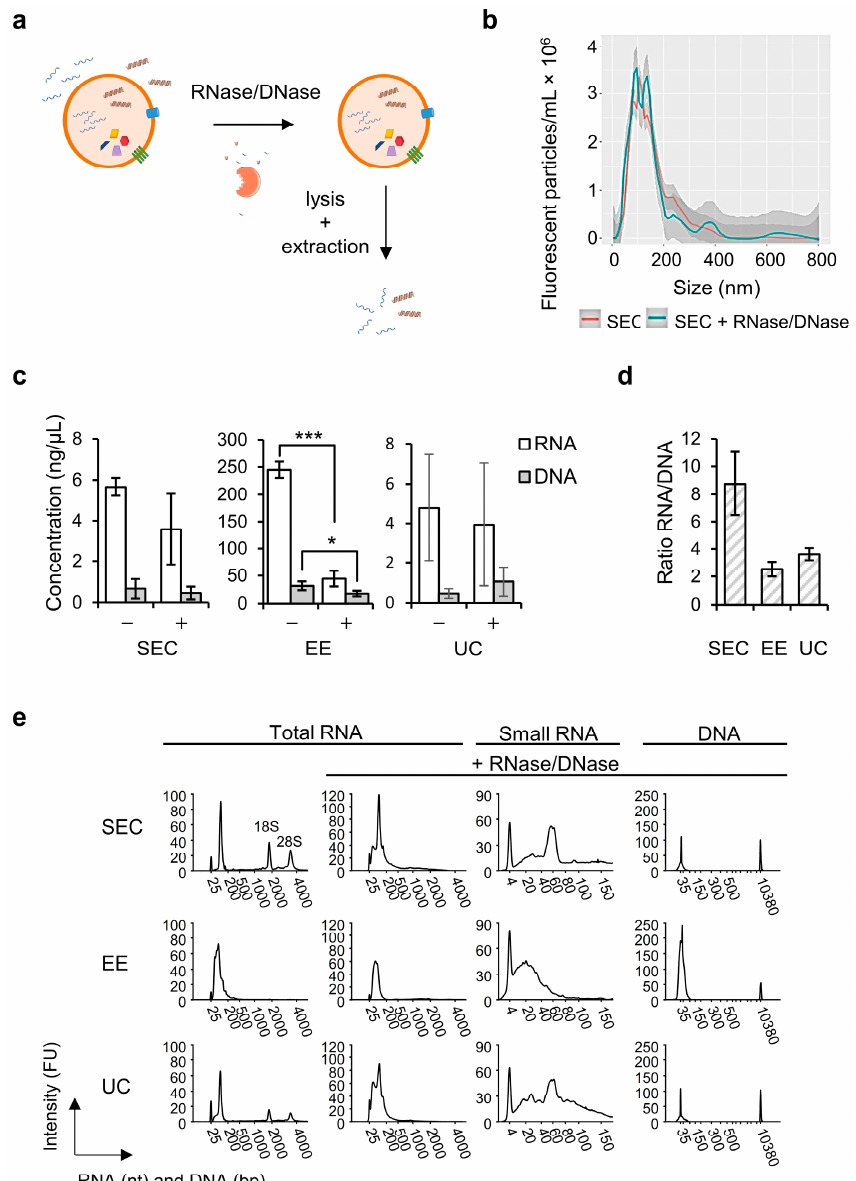
Figure 2. Characterization of intravesicular RNA and DNA species. ( a ) Schematic overview of DNase/RNase treatment before sEV lysis and sEV-contained nucleic acid extraction. ( b ) Nuclease treatment removes non-sEV encapsulated RNA and DNA, but leaves the sEV-membrane intact. Size distribution profiles of sEV samples separated by SEC that were either left untreated or treated with RNase/DNase, obtained by fluorescence NTA measured using a ZetaView TWIN. Samples were stained using the membrane intercalating dye cell mask green. The graph is shown as mean ± SD (n = 12) and is a representative of 3 independent measurements. ( c ) Concentration of total RNA and DNA in samples without treatment (-) and with RNase/DNase treatment (+) measured using the RNA HS and DNA HS assay, respectively, on a Qubit 2.0 Fluorometer. Data are represented as mean ± SD (N = 3). Statistically significant results after treatment with RNase/DNase are indicated by * for p -value ≤ 0.05 and *** for p -value ≤ 0.001. ( d ) Ratio of RNA over DNA with RNase/DNase treatment calculated from Figure 1c. ( e ) Fragment length distribution profiles of samples without treatment and with RNase/DNase treatment obtained using a Bioanalyzer 2100 and RNA 6000 Pico kit (total RNA), small RNA kit (small RNA) or High Sensitivity DNA kit (DNA). Representative profiles of three biological replicate experiments (N = 3) are shown. FU, fluorescence units; nt, nucleotides; bp, base pairs.